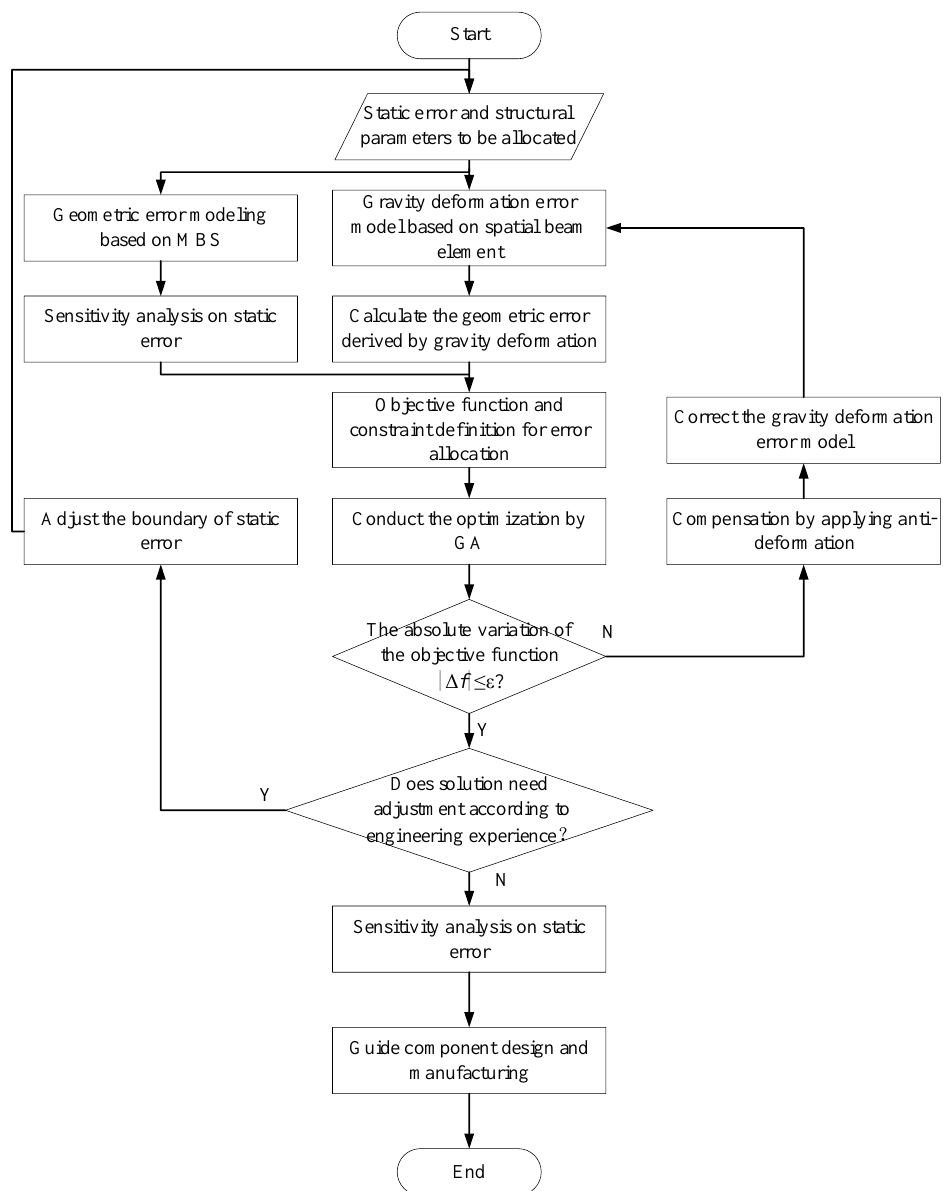
Figure 1. Flowchart of the heavy-duty machine tool precision design method based on gravity deformation modelling.